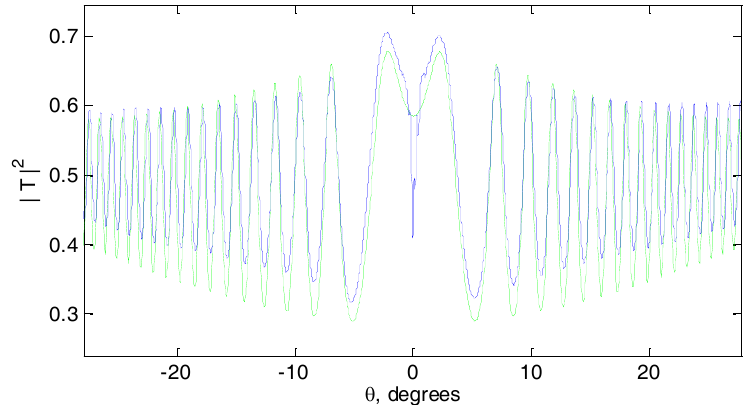
Fig. 4. Experimental (blue) and calculated (green) angle distributions of the coefficient of light transmission through the